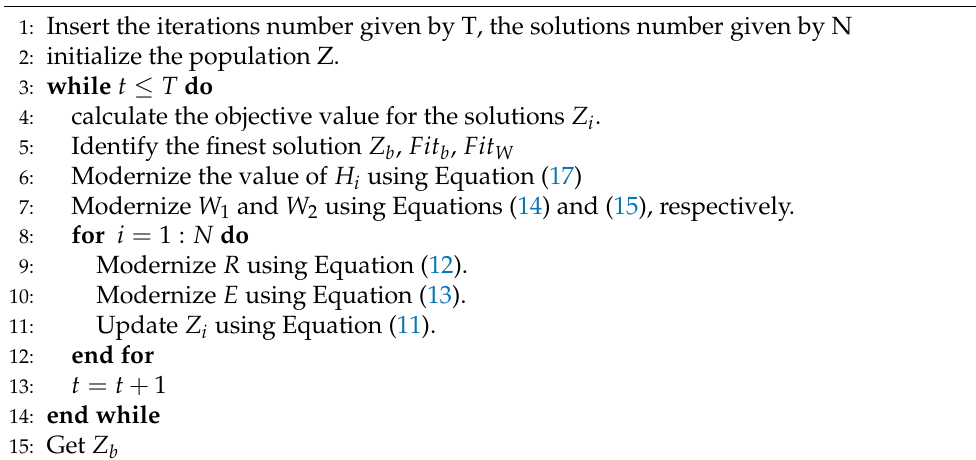
Algorithm 1 Steps of